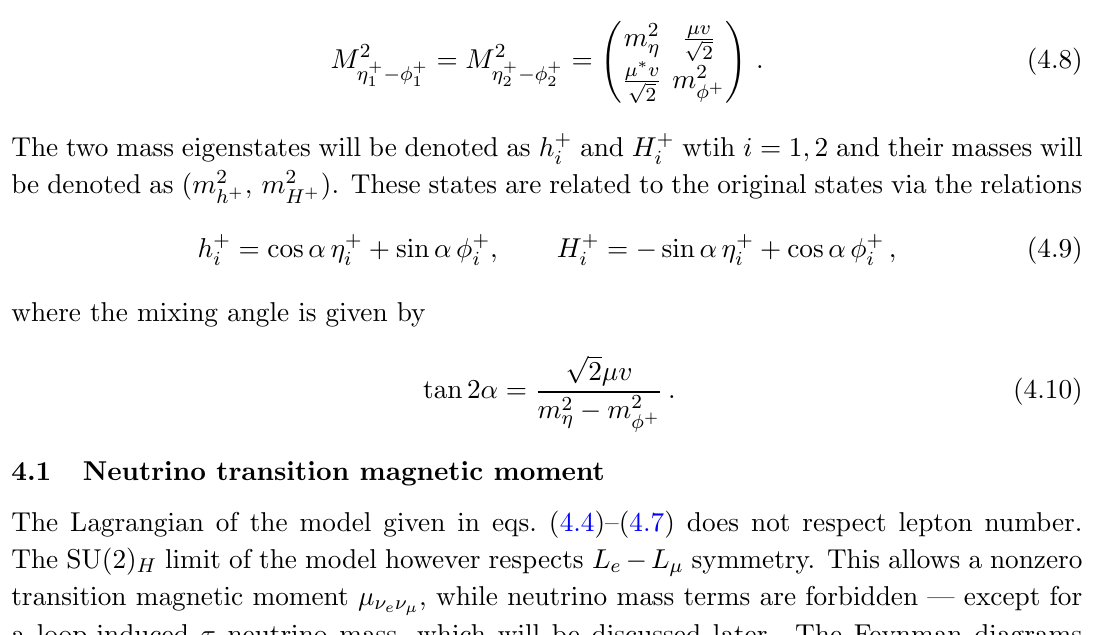
Figure 2 . Feynman diagrams generating neutrino transition magnetic moment (cid:22) (cid:23) model. There are additional diagrams where the photon is emitted from the (cid:28) lepton line. The same diagrams with the photon line removed would contribute to Majorana mass of the